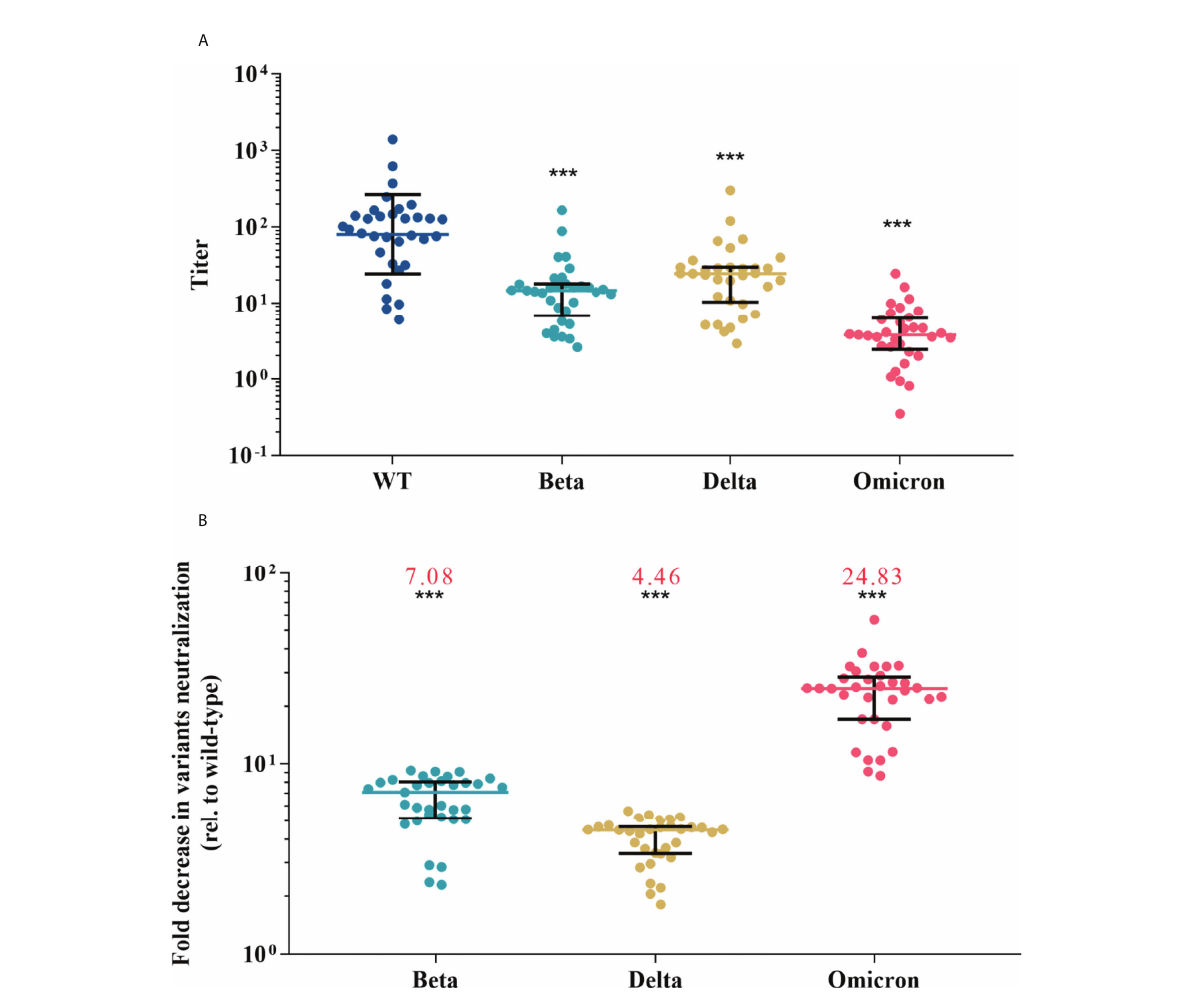
FIGURE 2 Neutralization responses against wild-type and variants of SARS-CoV-2 in convalescent COVID-19 patients. (A) Neutralization titers against wild- type and variants of SARS-CoV-2; colored bars represent geometric means and black bars represent geometric standard deviations. (B) Fold decrease in neutralization for each variant relative to wild-type virus, which was calculated by dividing IC50s titer of the SARS-CoV-2 variant by that of wild-type from the same vaccine sample; colored bars represent medians and black bars represent interquartile ranges; the median fold decrease in each variant neutralization post primary or booster vaccines is shown as a number in red. Statistical comparisons between groups were evaluated by Wilcoxon signed-ranked test. ***p<0.001 as compared with